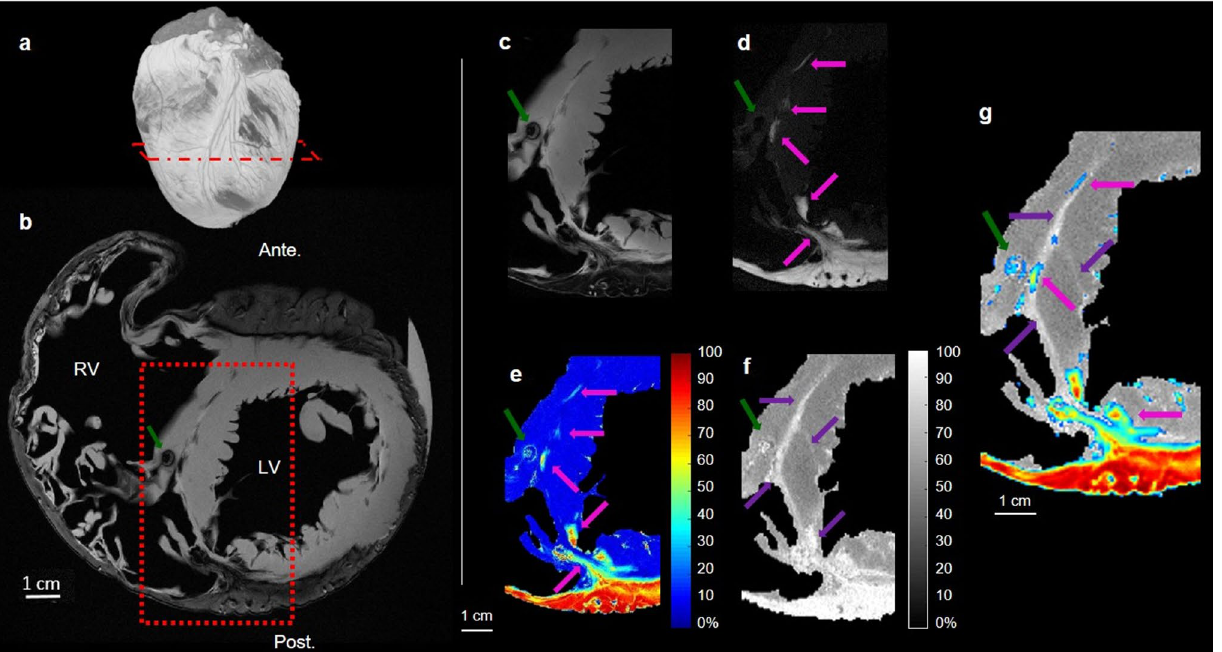
Figure 4. IDEAL outputs and MTR of the ARVC heart. Short axis view of the ARVC heart. A 3D rendering ( a ) showing water in grey, fat in white and the position of the slice in red, IDEAL first echo ( b ), proton density fat fraction map (PDFF) ( e ) calculated from water ( c ) and fat ( d ) images and MTR contrast ( f ) are shown. An overlay of the proton density fat fraction map on the MTR is displayed ( g ). All images show an artefact due to an air bubble trapped during the sample fixation (dark green arrow). ( d ) and ( e ) display fat infiltrations (dark green arrows) and (f) shows the presence of fibrosis (purple